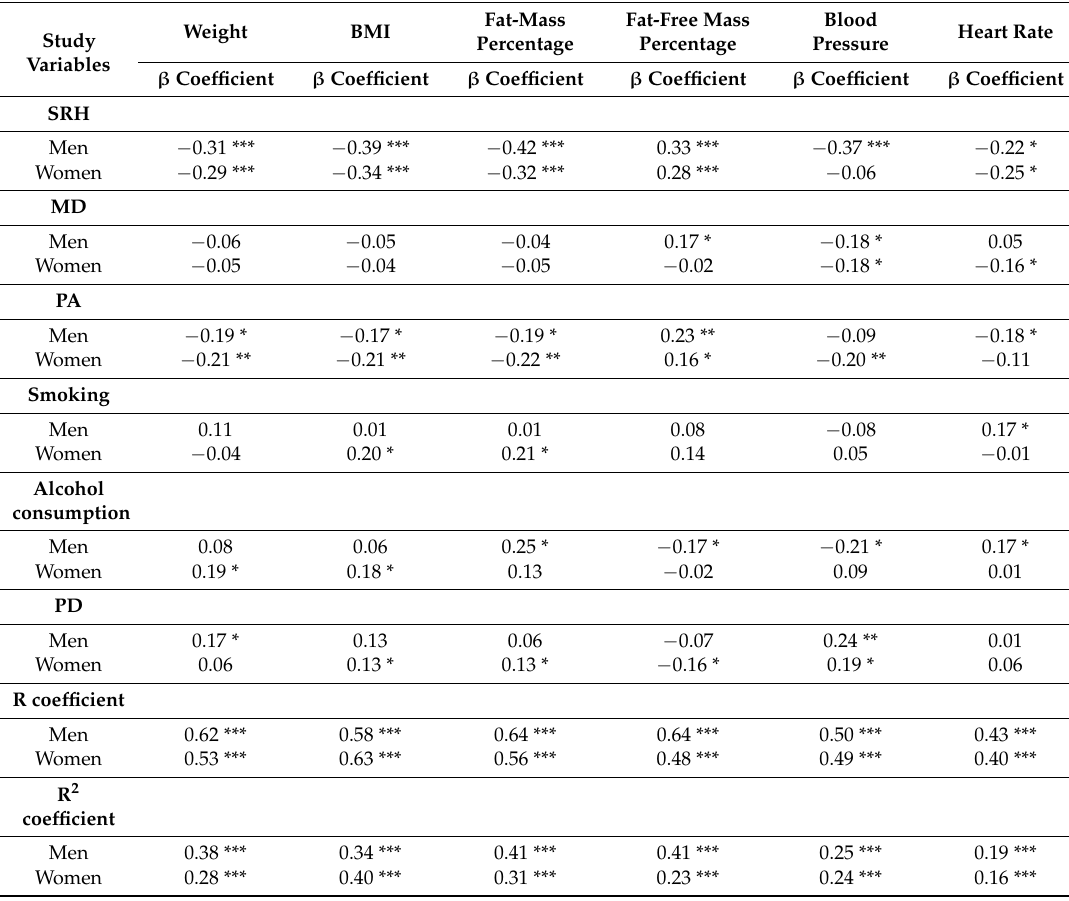
Table 3. Multiple regression analysis between the lifestyle factors and body composition parameters, stratified by